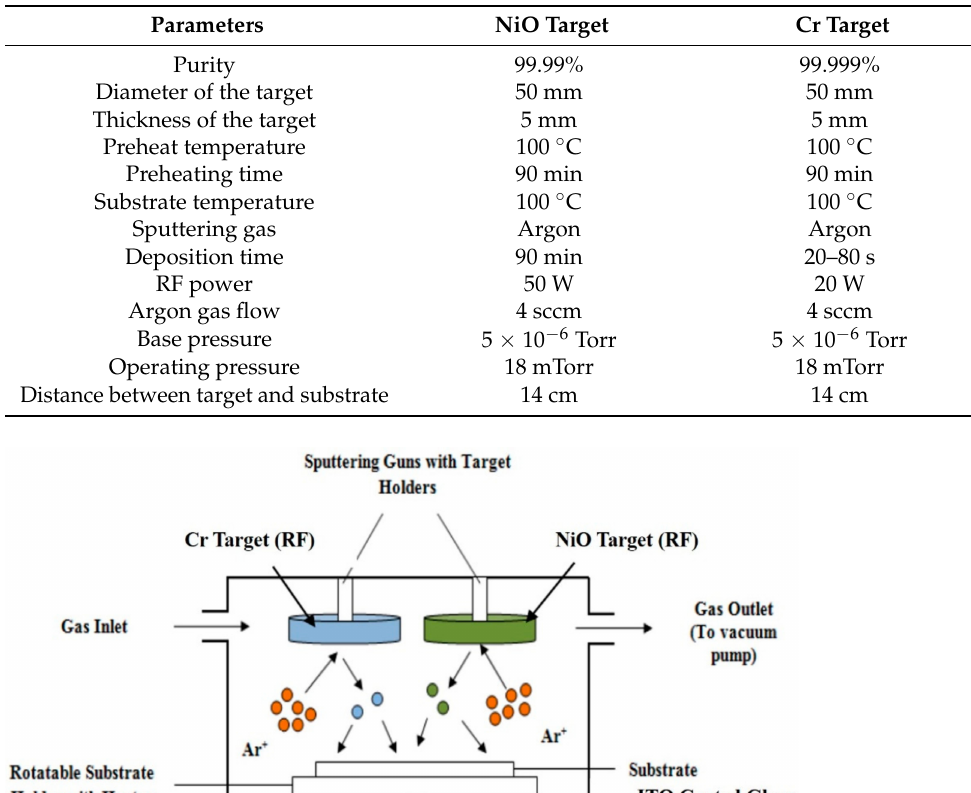
Table 1. Deposition parameters (RF Sputtering) of Cr-doped NiO.